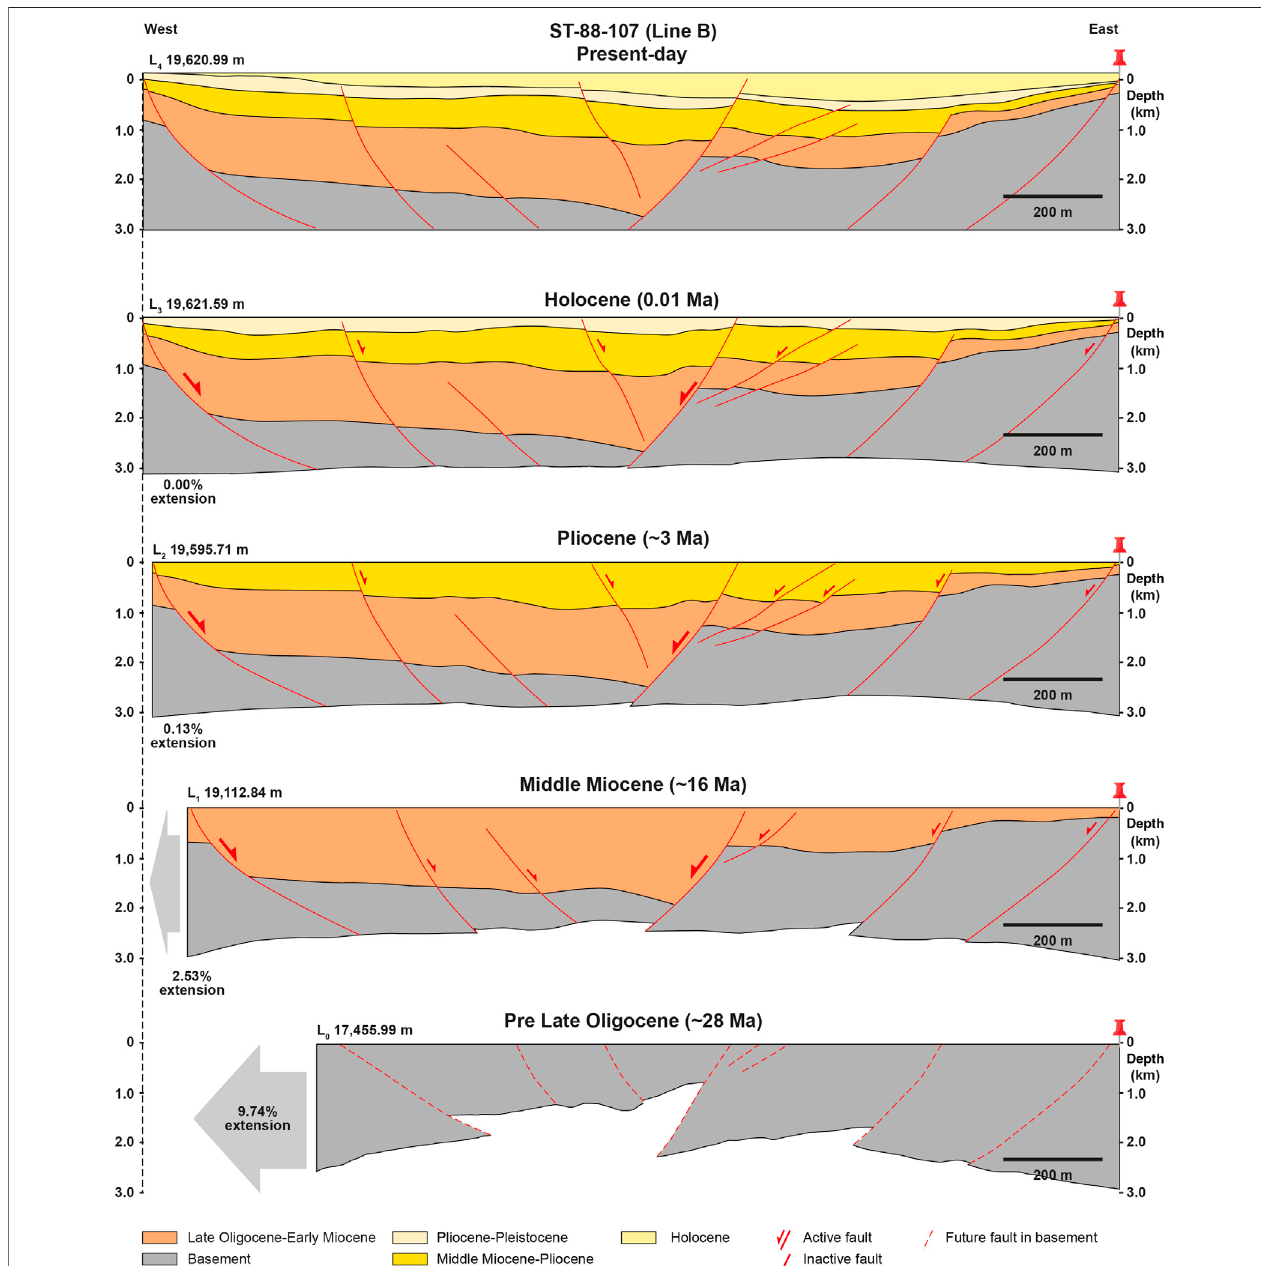
FIGURE 5 | The structural evolution of the Line B interpretation from the Late Oligocene to present. The extensional phases are captured in four phases. Ages, section lengths, and amount of extension are annotated for each time-step. The eastern end of each section is pinned for section length comparison.